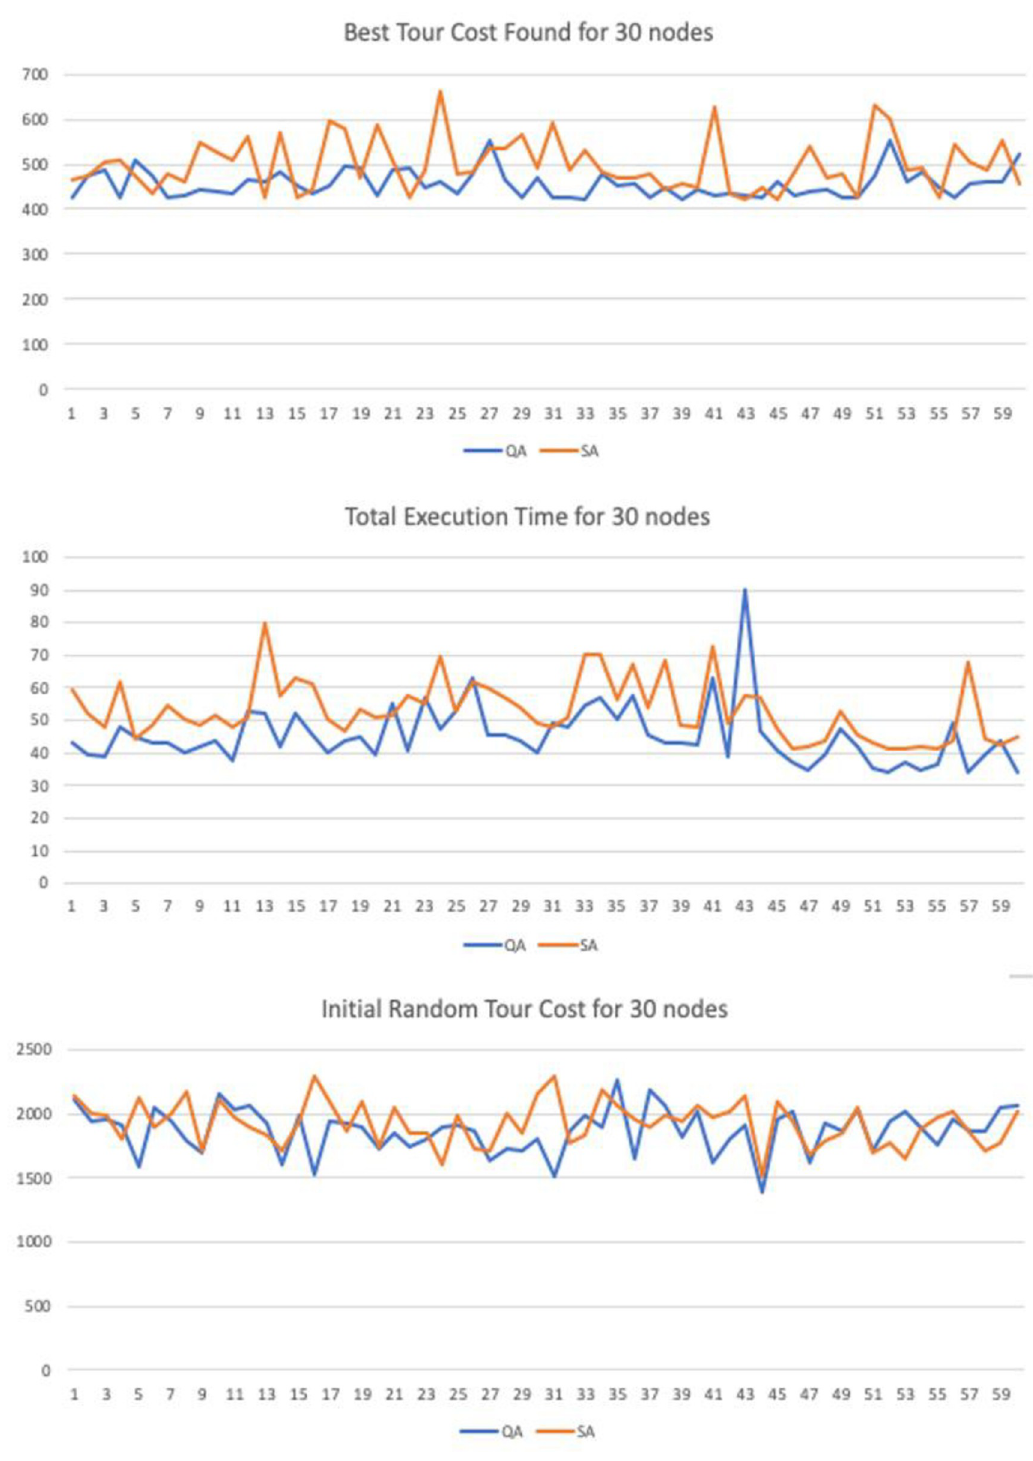
Fig 39. Chart with results for test cases with n = 30 nodes with sample size N = 60.